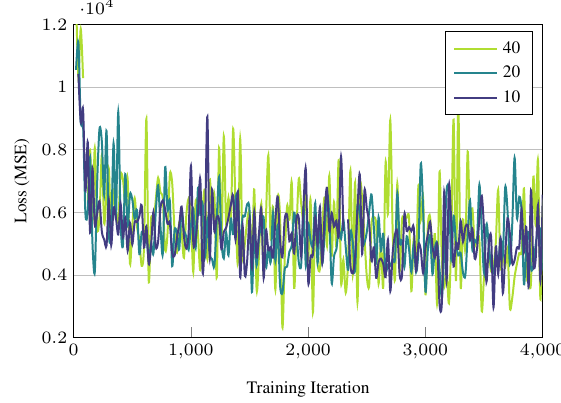
Figure 6. Convergence of the training loss for networks with different depths, i.e. , number of convolution + ReLU blocks. All three models converge to a very similar solution.